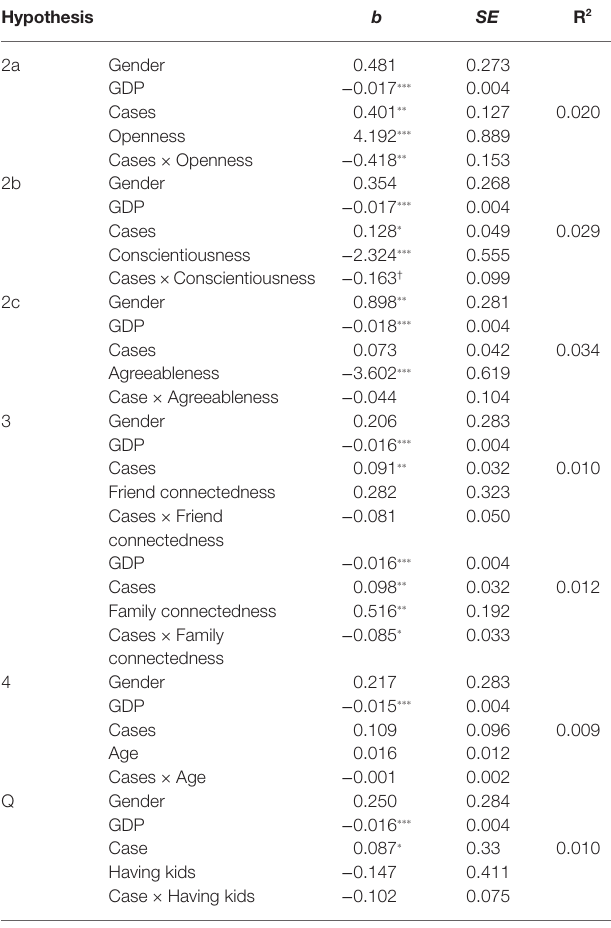
TABLE 3 | Moderation effects on the relationship between confirmed cases on the negative affect of working adults ( N = 2,231). Hypothesis b